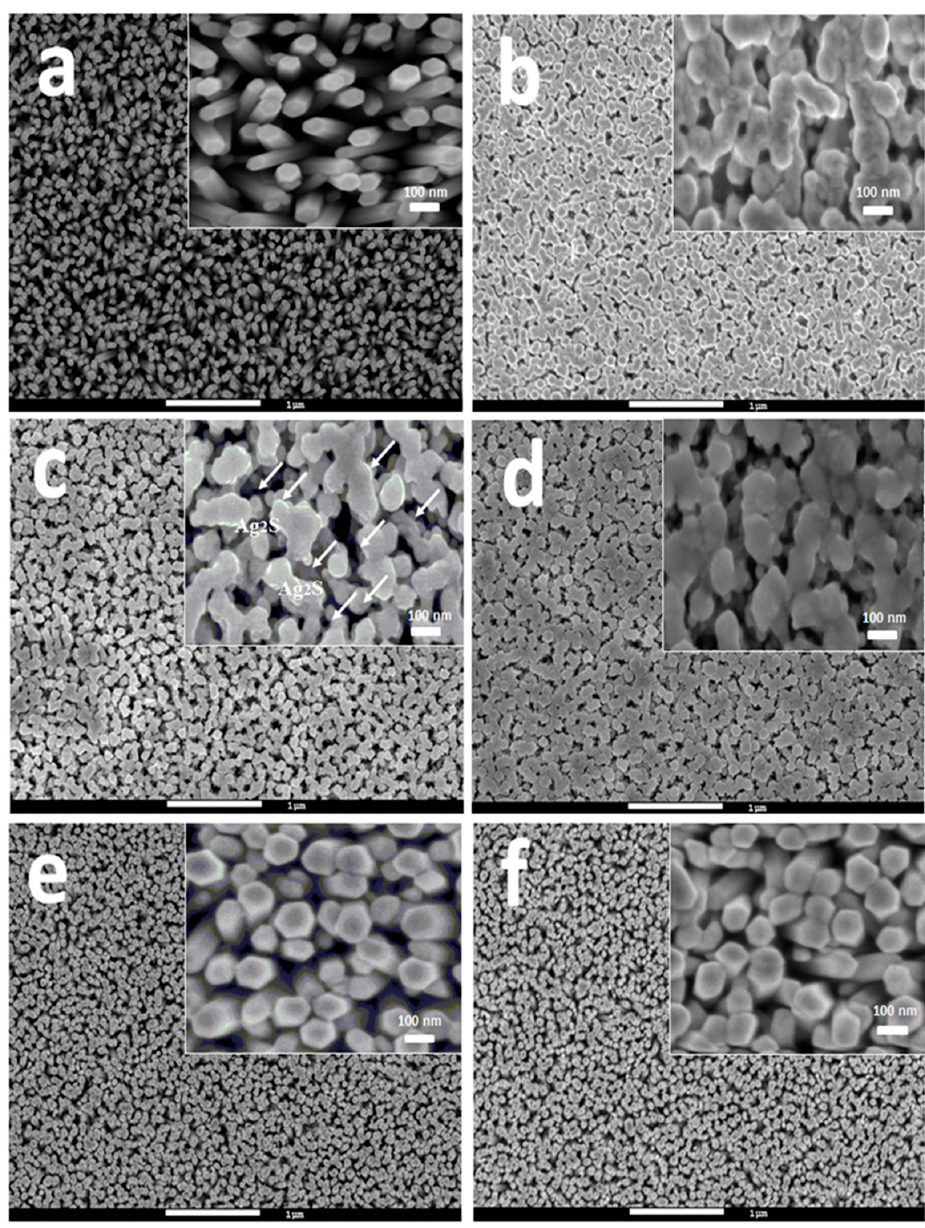
Figure 5. FESEM images of ZnO NRs ( a ); Ag 2 S/ZnO NRs/ITO with various concentrations of CS(NH 2 ) 2 ( b ) 0.01 M; ( c ) 0.03 M; ( d ) 0.05 M; ( e ) 0.08 M; and ( f ) 0.1 M. The figures’ insets show the FESEM images at a higher magnification.